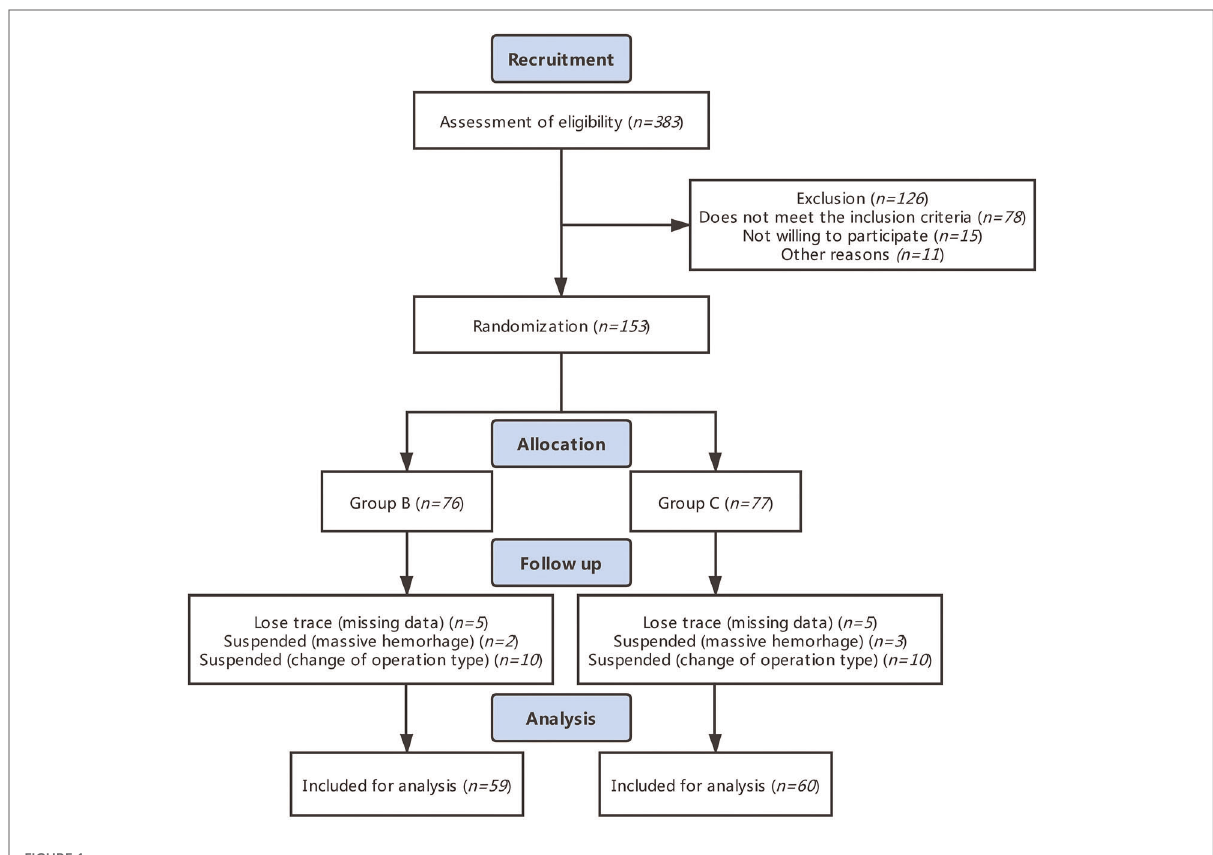
FIGURE 1 CONSORT fl ow